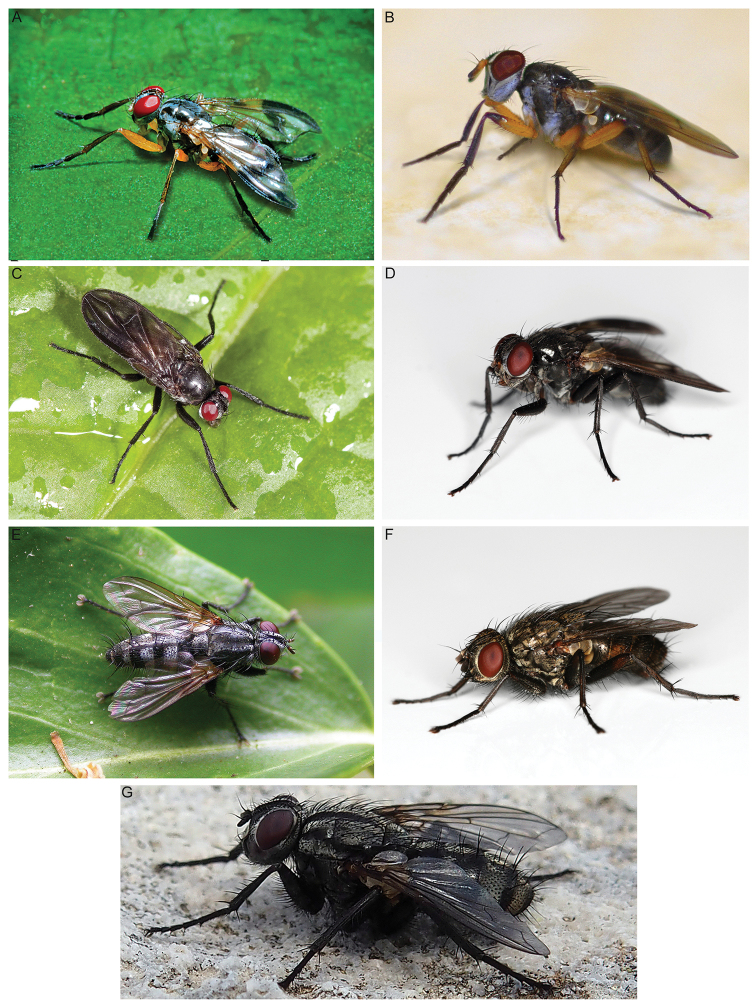
Rhinophoridae photographed in nature. ABezzimyia sp. (Ecuador) BBixinia
winkleri (Australia) CMarshallicona
quitu (Ecuador) DPaykullia
maculata (Finland) EStevenia sp. (Italy) FTricogena
rubricosa (Finland) GPhyto sp. (Italy). Photographs by Steve Marshall (A, C), P.C. (B, E, G), Håkon Haraldseide (D, F).